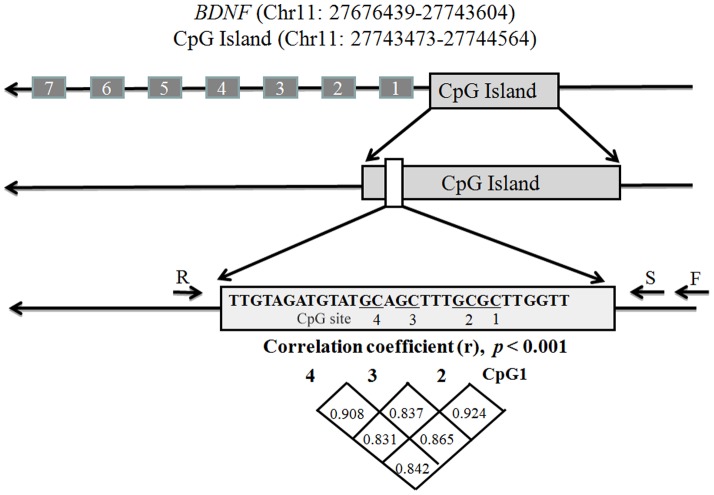
Correlation among 4 CpGs in BDNF promoter.F: Forward primer, R: Reverse primer, S: Sequencing primer.